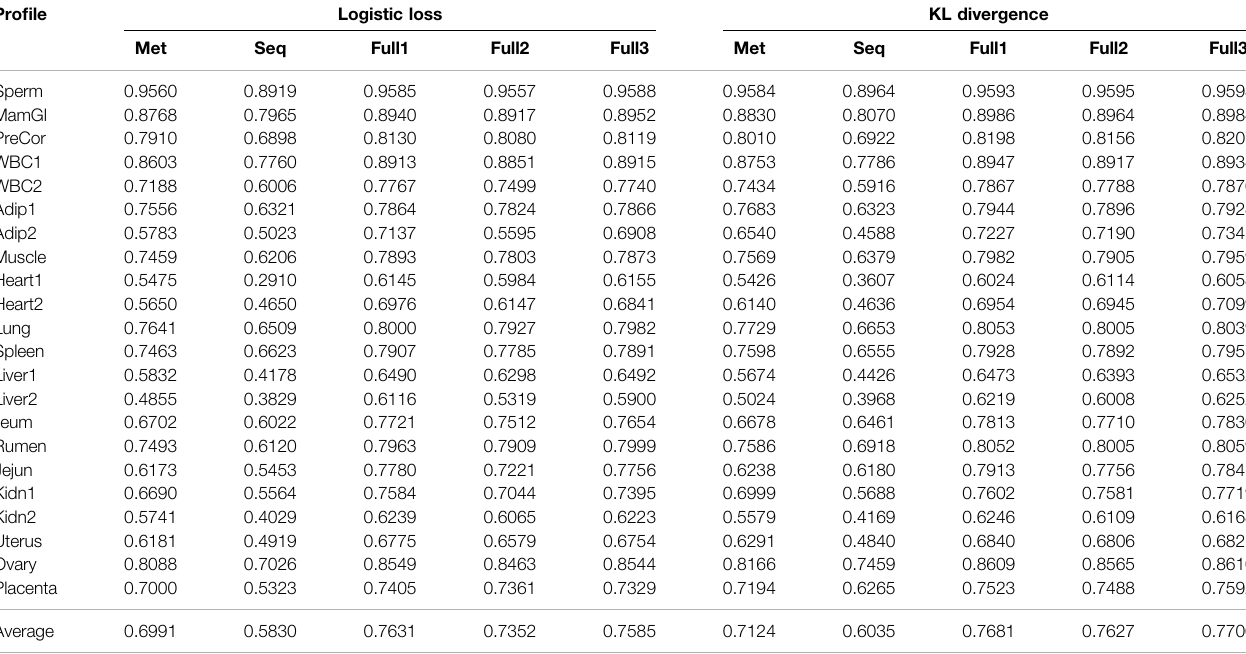
TABLE 2 | F1 score of models obtained on source pro fi les. Models trained using both logistic loss and KL divergence as the objective function are included for comparison. Pro fi le Logistic loss KL divergence Met Seq Full1 Full2 Full3 Met Seq Full1 Full3 Sperm